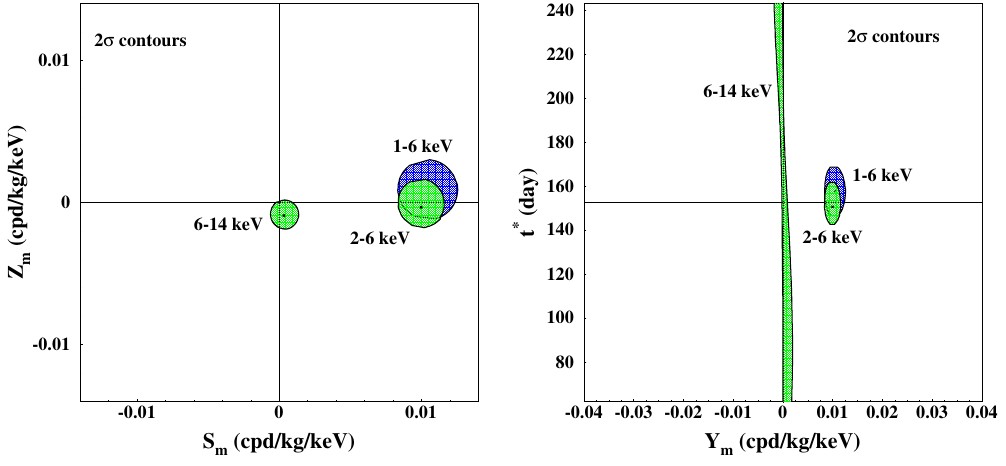
Figure 6. 2 σ contours in the plane ( S m , Z m ) (left) and in the plane ( Y m , t ∗ ) (right) for: (i) DAMA/NaI, DAMA/LIBRA–phase1 and DAMA/LIBRA–phase2 in the (2–6) keV and (6–14) keV energy ranges (light areas, green online); (ii) only DAMA/LIBRA–phase2 in the (1–6) keV energy interval (dark areas, blue online). The contours are obtained by maximum likelihood method. A modulation amplitude is found in the lower energy ranges and the phase agrees with the expectation for DM induced